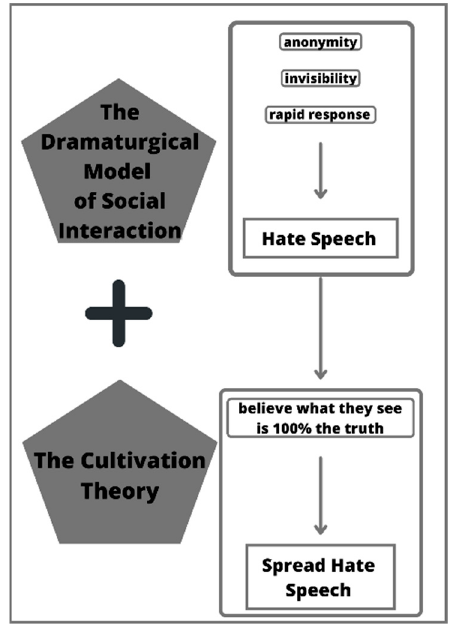
Figure 1. this figure explains how both theories are related to hate speech in the cyberworld. Figure 1. This figure explains how both theories are related to hate speech in the